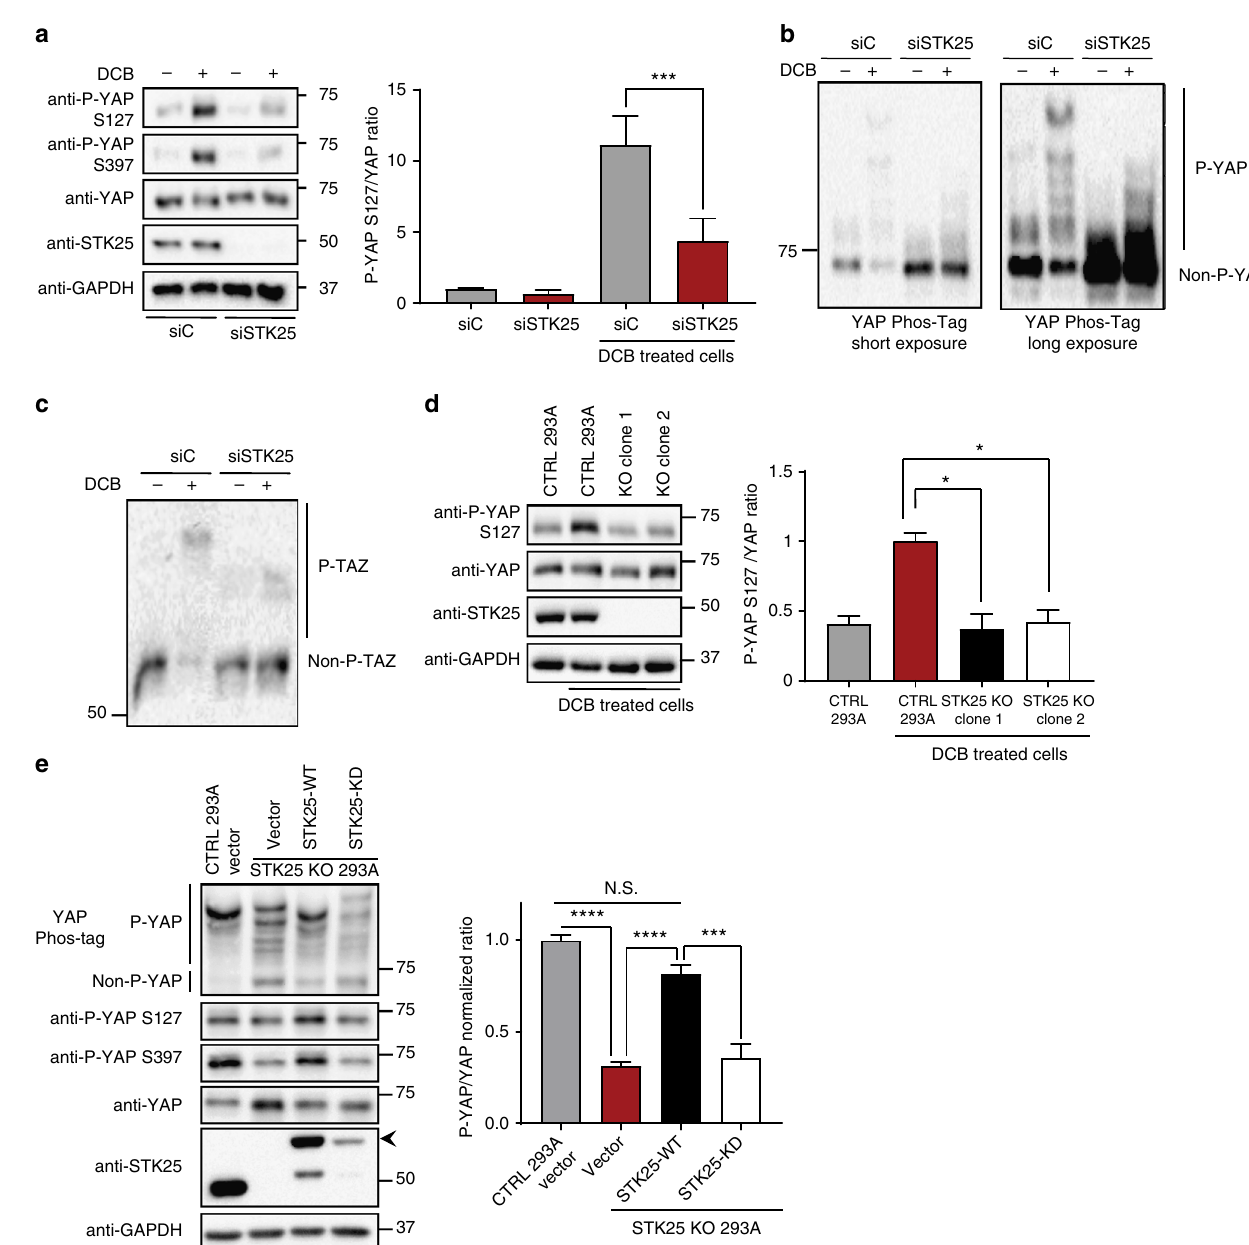
Fig. 1 STK25 regulates Hippo activation in response to loss of cytoskeletal tension. a Immunoblot and quantitation of phosphorylated YAP levels following treatment with 10 µ M DCB in HEK293A cells transfected with the indicated siRNA ( n = 6; *** p < 0.001, unpaired t -test). b Global phosphorylation status of YAP was assessed using Phos-tag gel electrophoresis following treatment with 10 µ M DCB in HEK293A cells transfected with either control siRNA or STK25 siRNA. Shifted bands indicate degrees of YAP phosphorylation. c TAZ phosphorylation status was assessed using Phos-tag gel electrophoresis following treatment with 10 µ M DCB in HEK293A cells transfected with either control siRNA or STK25 siRNA. d Immunoblot and quantitation of phosphorylated YAP levels following treatment with 10 µ M DCB in either control HEK293A stably expressing Cas9 and a non-targeting sgRNA or STK25 KO 293A stably expressing Cas9 together with either sgRNA 1 (Clone 1) or sgRNA 2 (Clone 2) targeting STK25 ( n = 4; * p < 0.05, one-way ANOVA with Dunnett ’ s post-hoc analysis). e Immunoblot and quantitation of phosphorylated YAP levels in control 293A cells and STK25 KO 293A cells